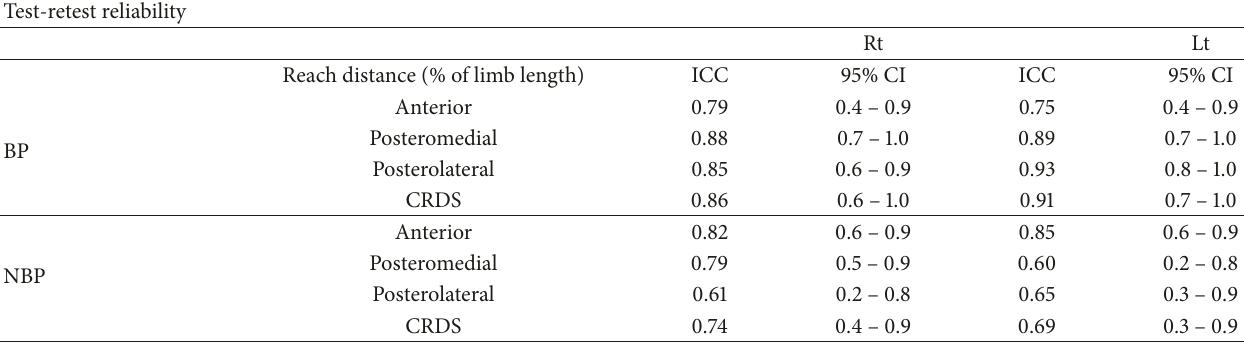
Table 4: Intraclass correlation coefficients with 95% confidence interval for test-retest reliability of subjects with and without back pain on the SEBT.